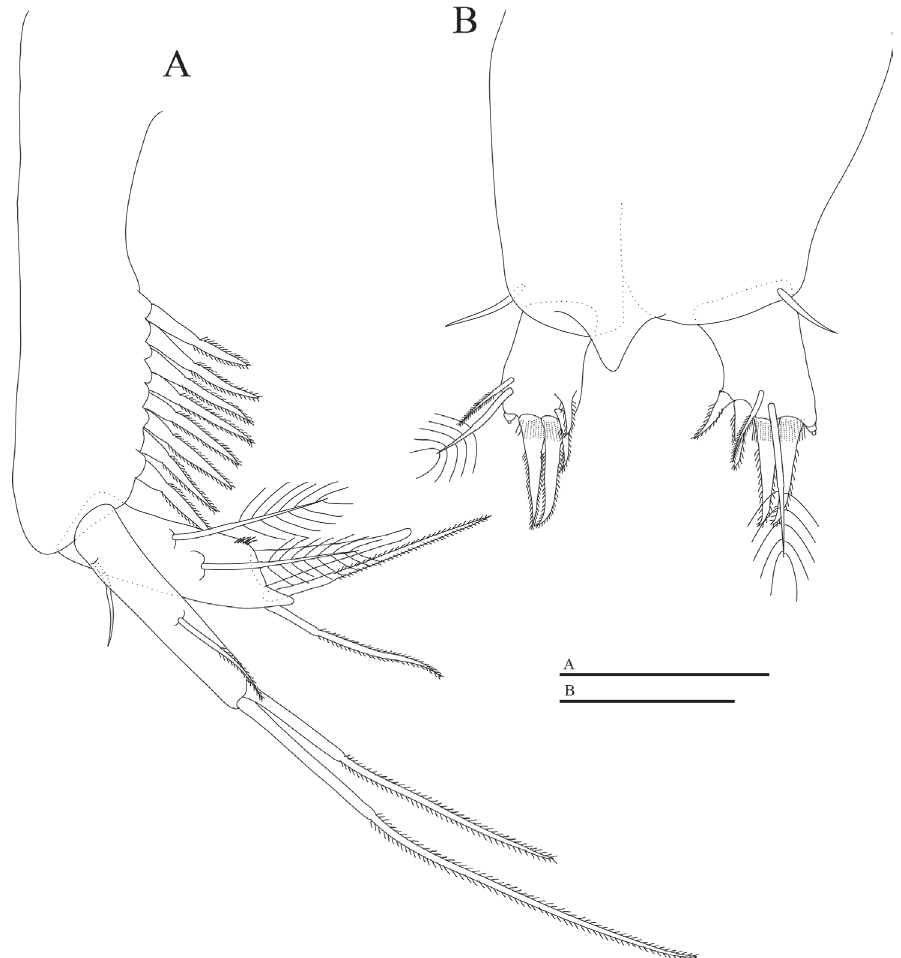
Figure 5. Hangangbathynella mihoensis sp. nov., holotype male A pleotelson and furcal rami (dorsal) B uropod (lateral). Scale bars: 0.05